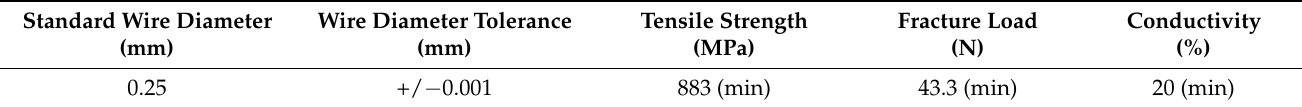
Table 4. Properties of zinc-coated brass wire.